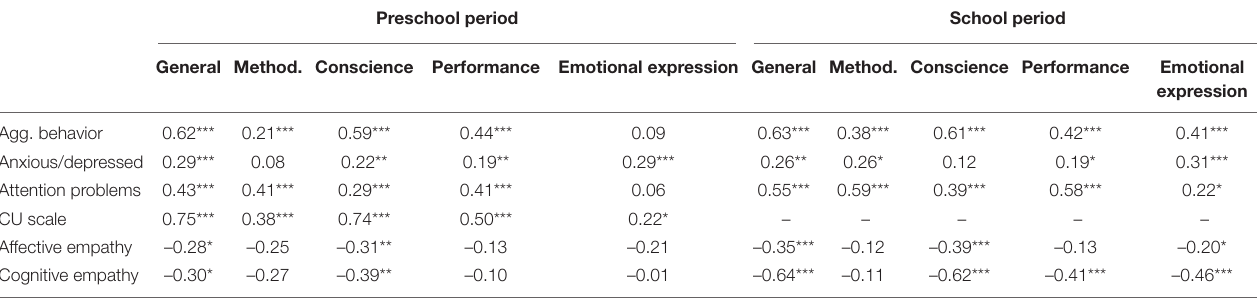
TABLE 5 | Latent correlations between the ICU second-order and first-order factors and external variables according to the age period. Preschool